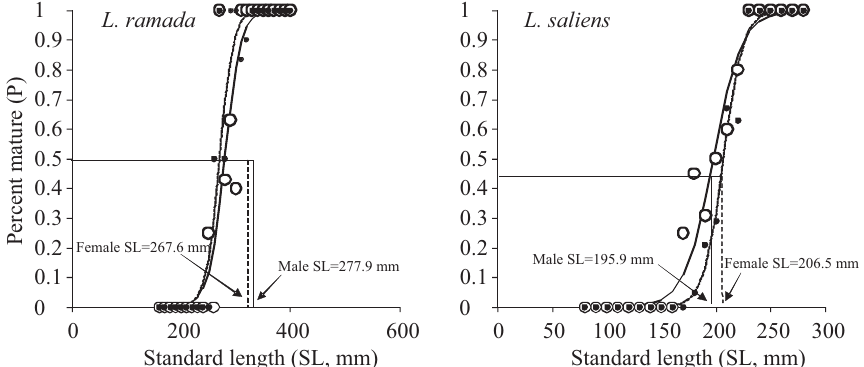
Fig. 5. Proportion of mature (%) males and females of Liza saliens and Liza ramada by size class (SL, 10 mm) caught during the sampling period; Symbols: (and continuous line) = males; (and dashed line) =